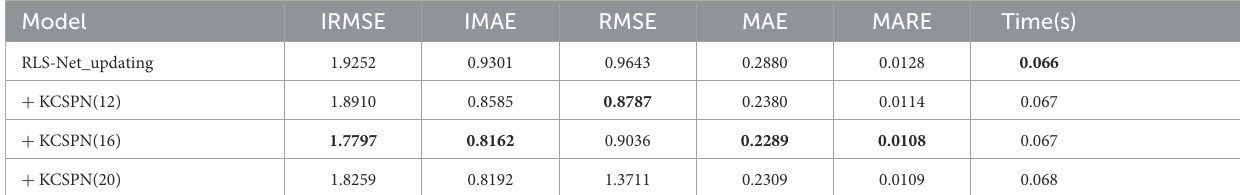
TABLE 6 Results of the kernel-connected depth refinement